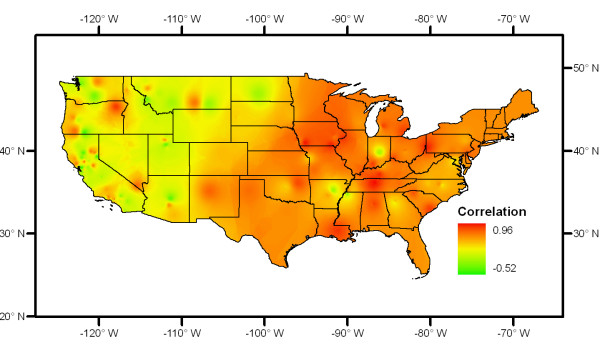
Surface of Pearson's correlation between PM2.5 and AOD.